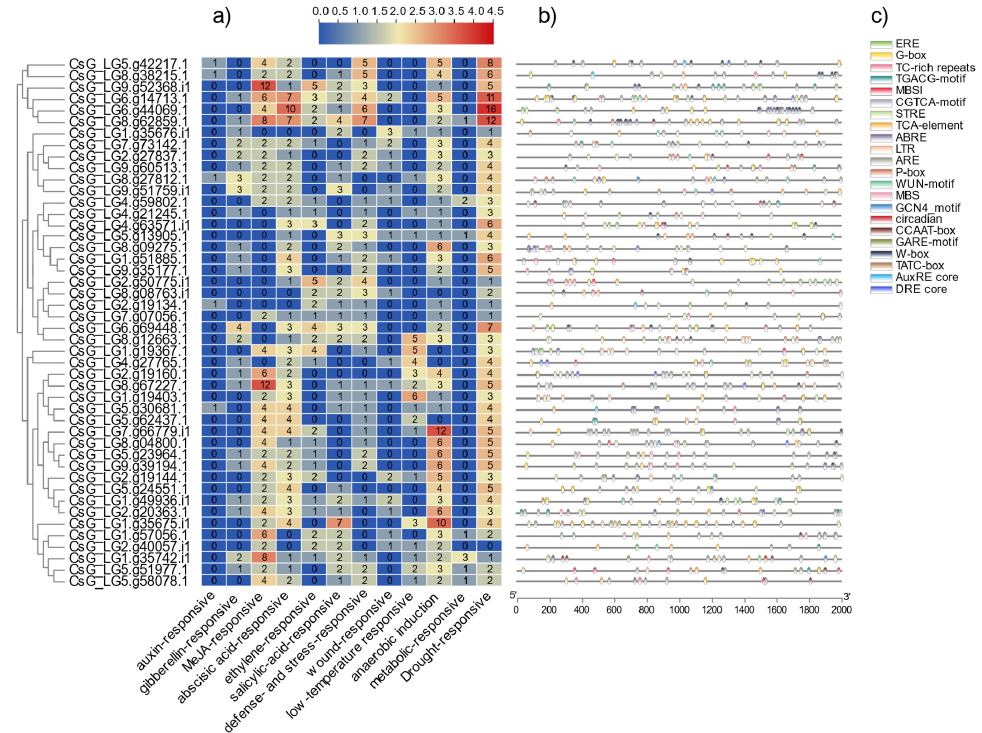
Figure 5. Putative cis-elements and transcription factor binding sites in the promoter regions of NF-Y genes from C. seticuspe . ( a ) The color and number of the grid indicate numbers of different cis-acting elements in these CsNF-Y genes. ( b , c ) The colored blocks represent different types of cis-acting elements and their locations in each CsNF-Y gene.